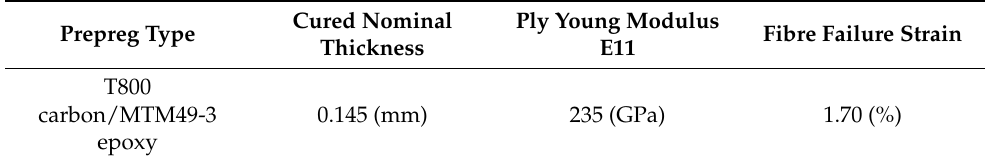
Table 1. Characteristics of the utilized